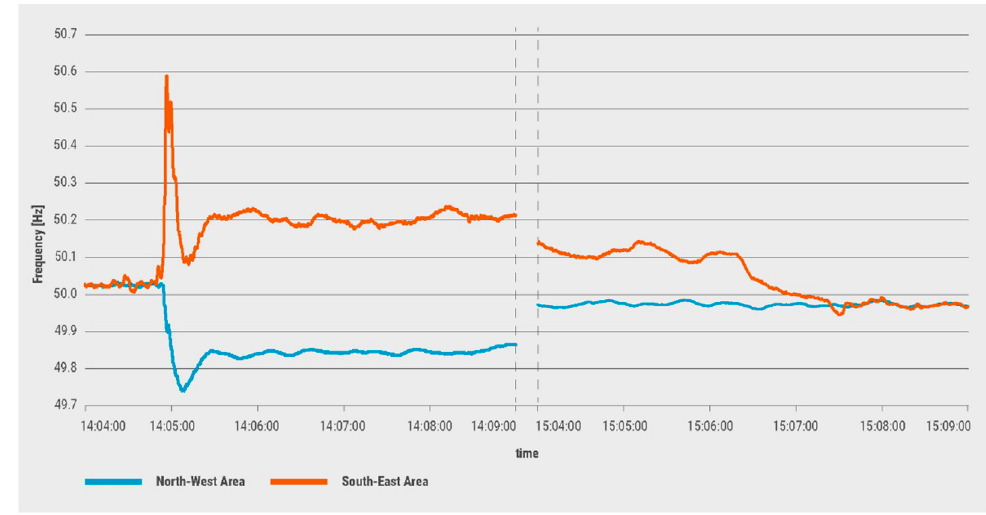
Figure 6. European frequency during the event on 8 January 2021.